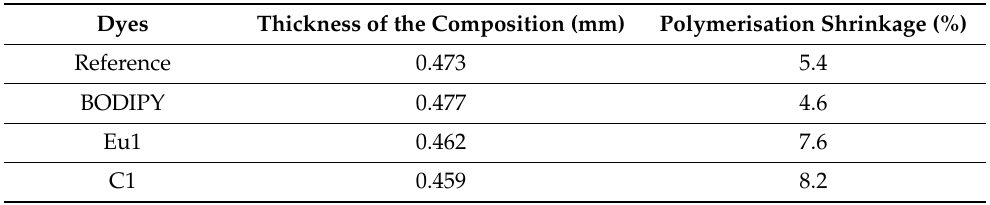
Table 2. Comparison of composition thickness and polymerisation shrinkage for the studied formulations.